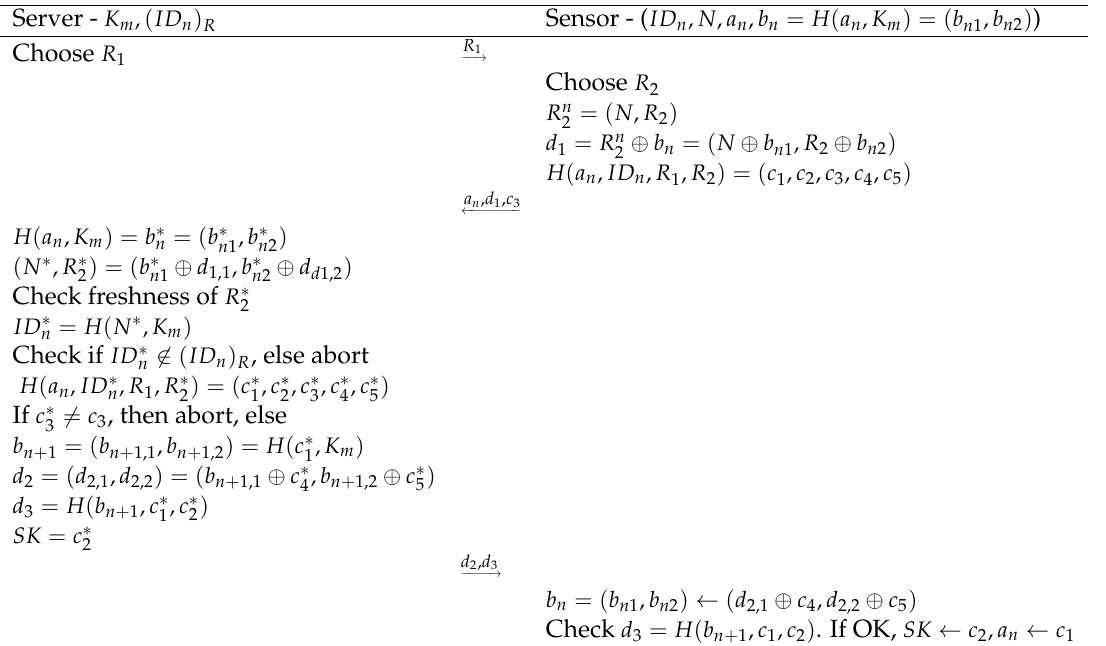
Figure 3. Steps and computations in the proposed authentication and key agreement scheme without